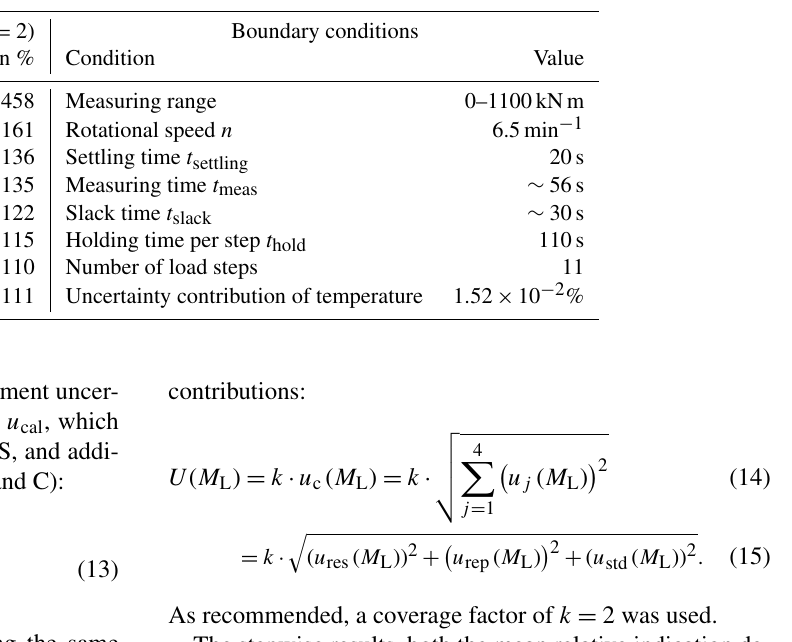
Table 3. Expanded ( k = 2) absolute measurement uncertainty U for the best expected value for the mean relative indication deviation ¯ q and overview of the prevailing boundary conditions during the